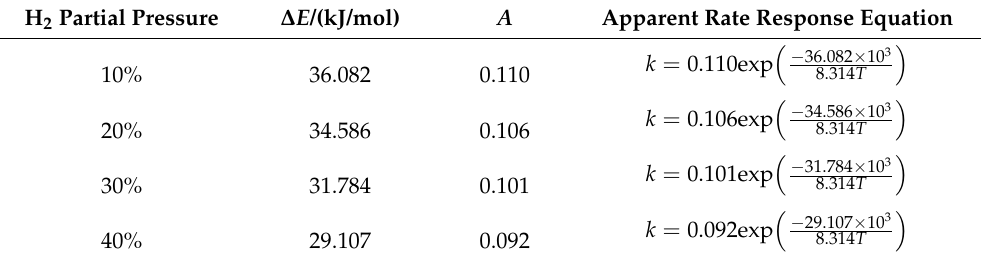
Table 5. Relationship between ln k and 1/ T in different reducing